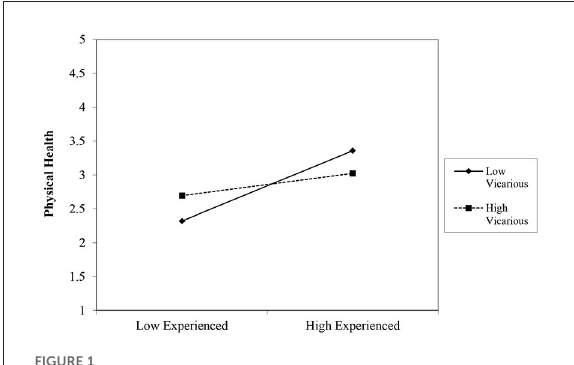
FIGURE1 Interaction of experienced discrimination and vicarious discrimination on physical health. N = 308. Experienced, experienced discrimination; Vicarious, vicarious